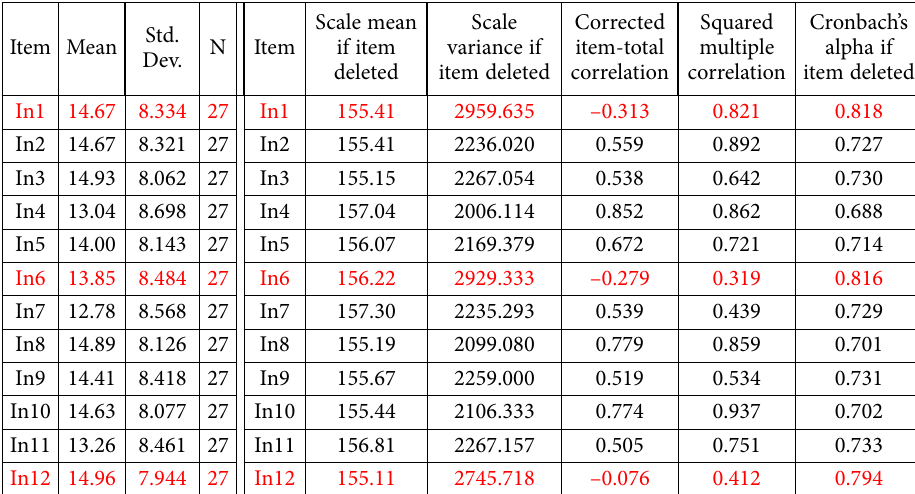
Table 2. SPSS  , Item Statistics and Item-Total